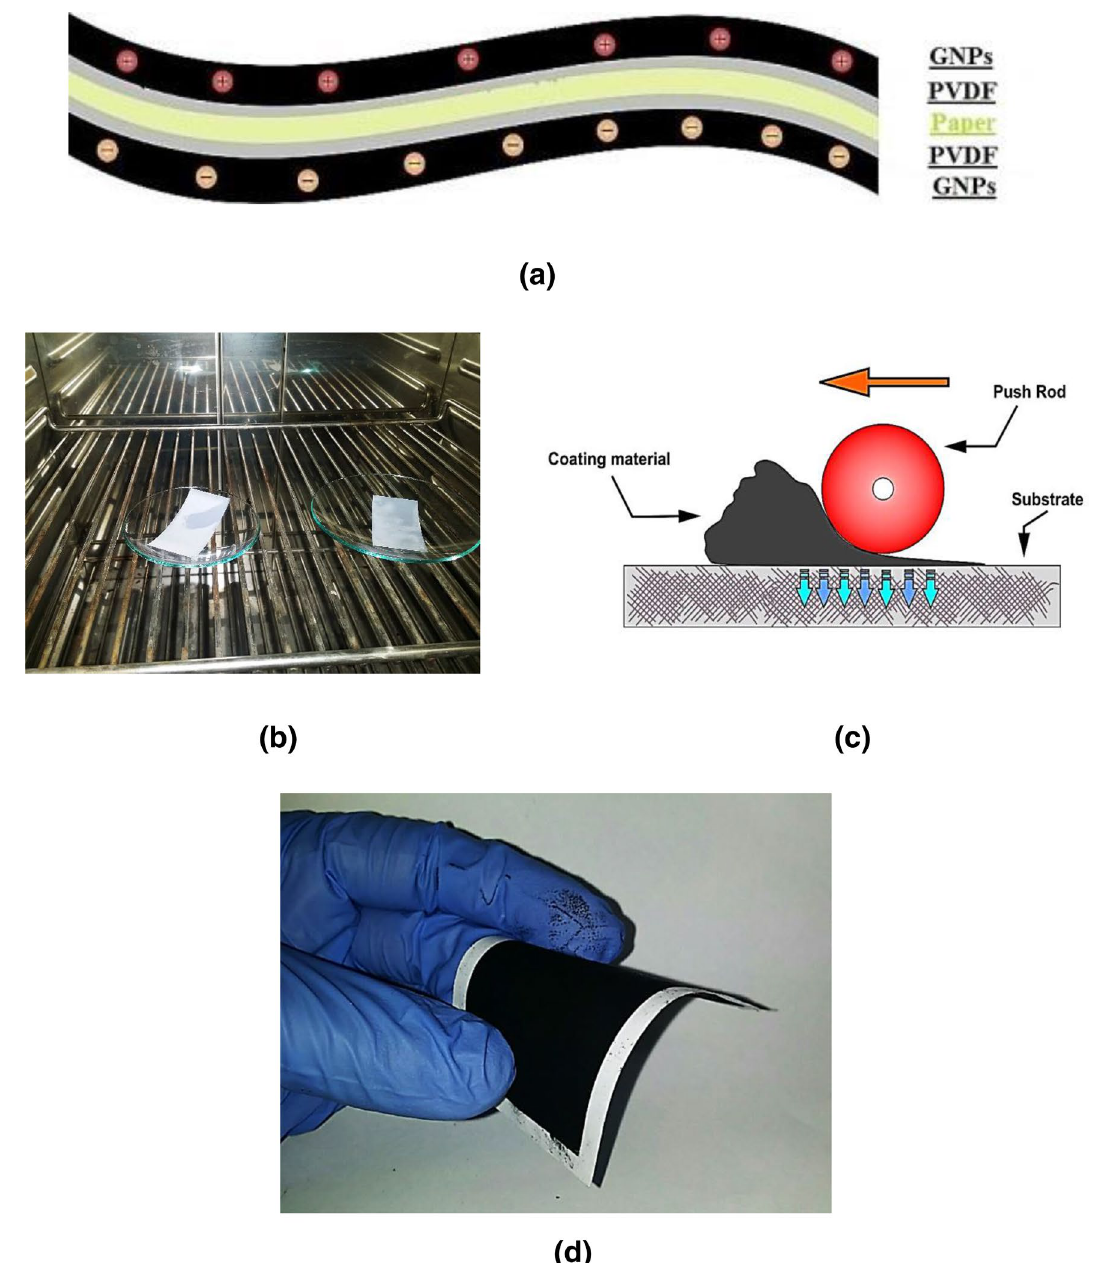
Fig. 2 a Schematic of the paper supercapacitor with the structure of PVDF/NMP gel electrolyte and GNPs electrodes, b paper with gel electro- lyte film in the oven, c schematic of the push coting method, d image of the fabricated paper